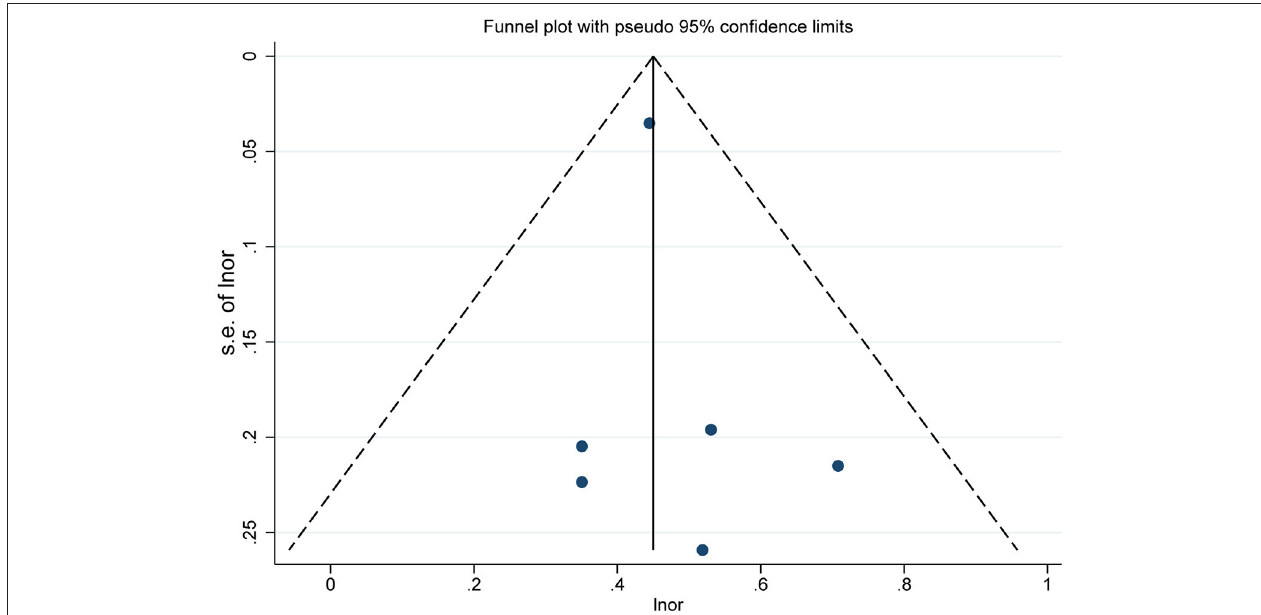
FIGURE 4 | Forest plot of maternal smoking during pregnancy and childhood caries (longitudinal